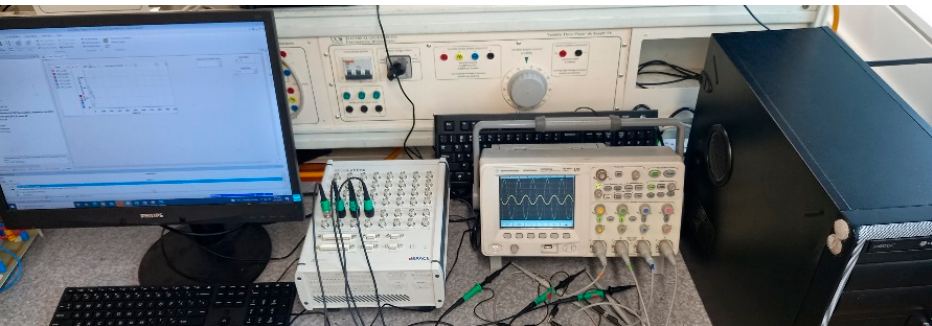
Figure 16. Real-time emulation of the MMC-EB charging system.